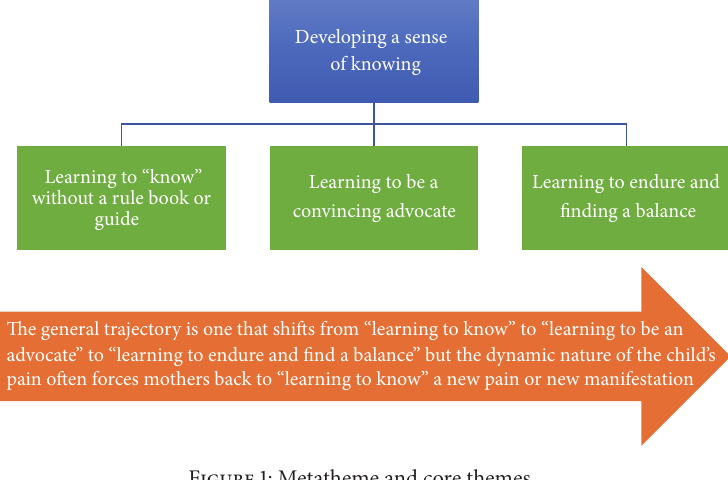
Figure 1: Metatheme and core